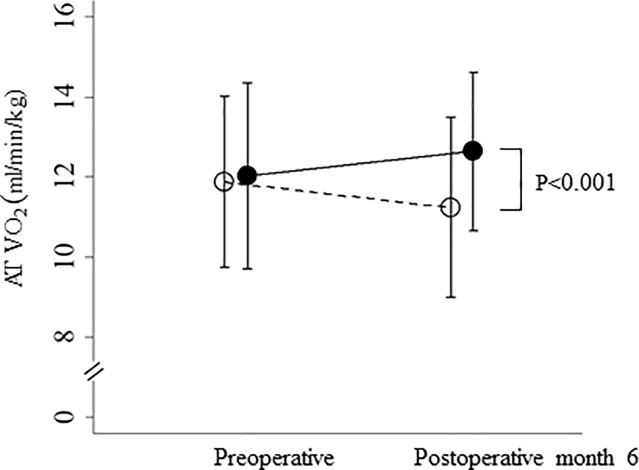
Perioperative changes in AT VO2 in the two groups.AT VO2 in the maintenance (closed circles) and decrease (open circles) groups after liver resection. Data are shown as the mean ± standard deviation. AT VO2: anaerobic threshold as the point between carbon dioxide production and oxygen consumption per unit of time.